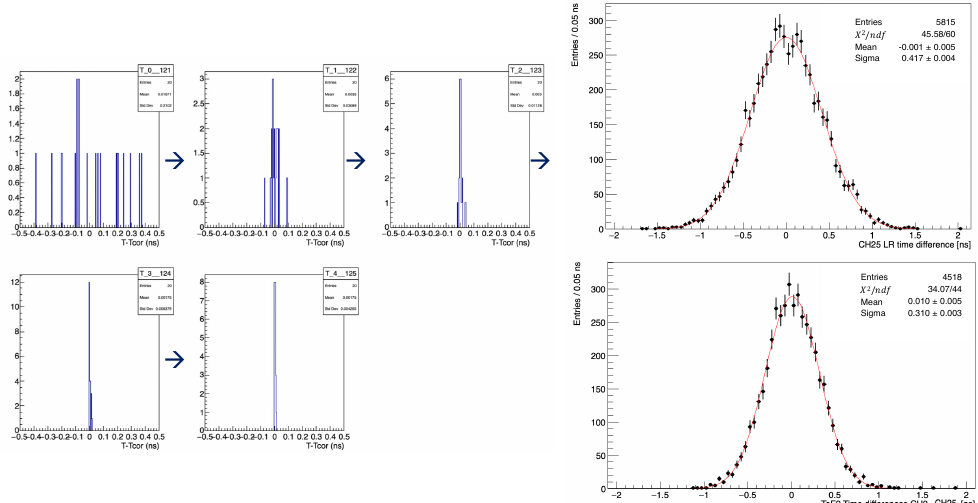
Figure 13. Overview of the timing alignment procedure ( left ): histogram of offset residuals after 5 iterations of the alignment algorithm. Top-right : example distribution of MIP timing differences between the left and right channels of the dual readout for the central crystal. Bottom-right : example of timing differences between two channels after 2D ToF correction and timing